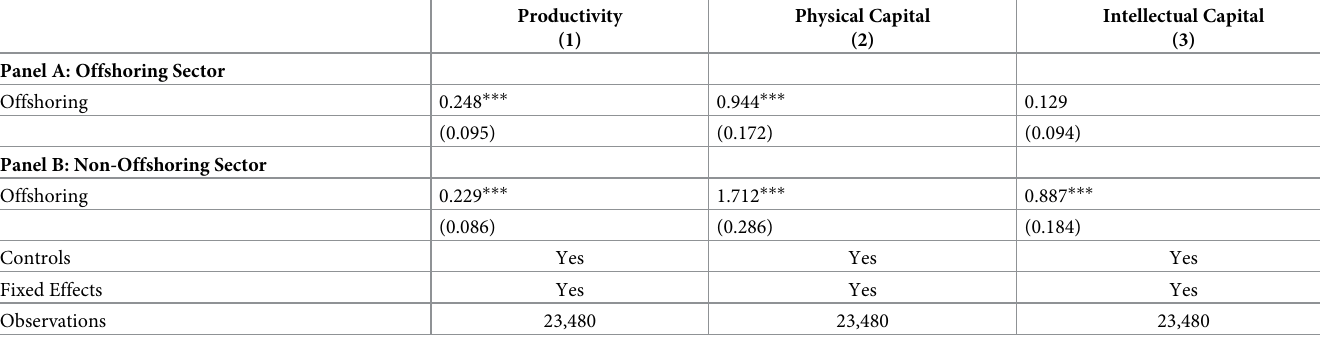
Table 4. Offshoring effects on productivity and capital investment by